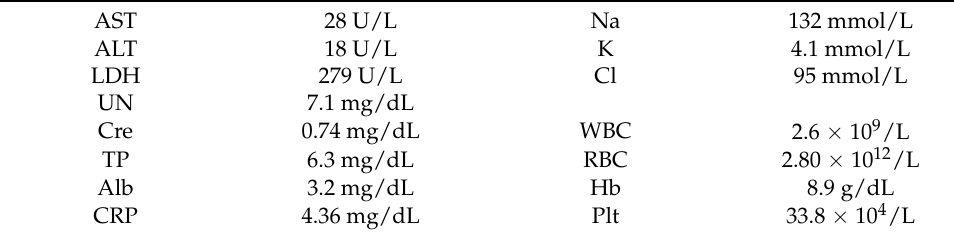
Table 1. Laboratory test data on